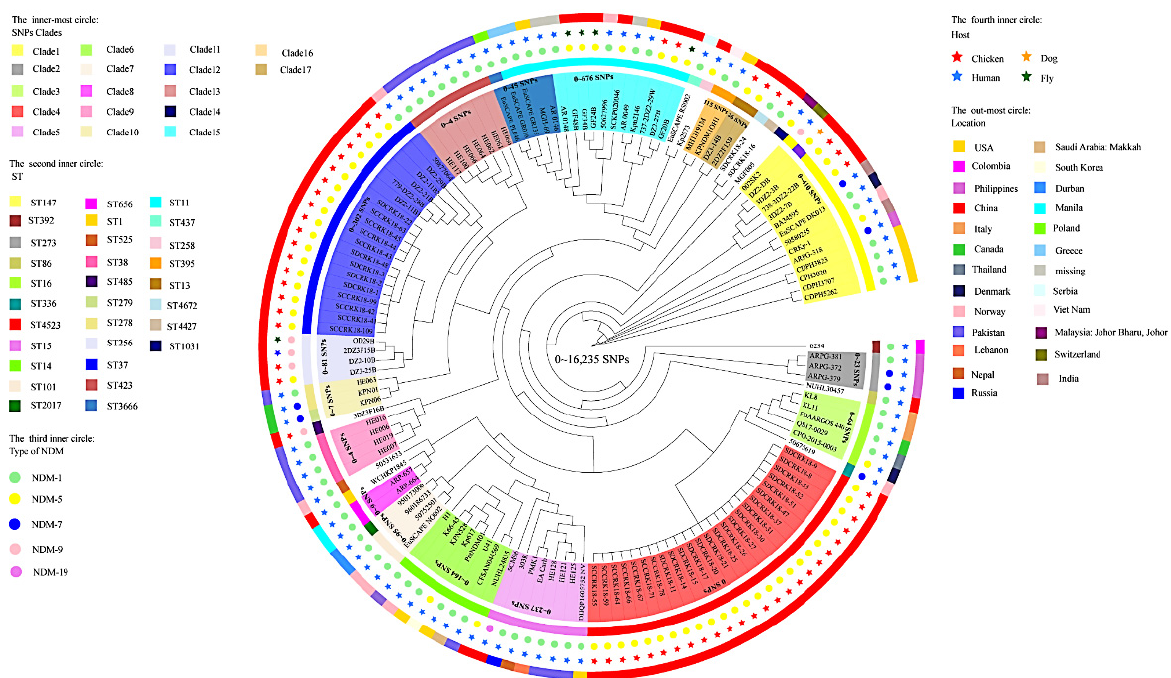
Figure 3. Core genome evolution relationship of the bla NDM gene carrying K. pneumoniae strains (40 strains from this study, 97 strains from the database). The genomic sequence of K. Pneumoniae KCTC2242 (accession number CP002910) was selected as a reference genome. The SNPs, STs, NDM, host, and country were indicated by different colors and shapes.